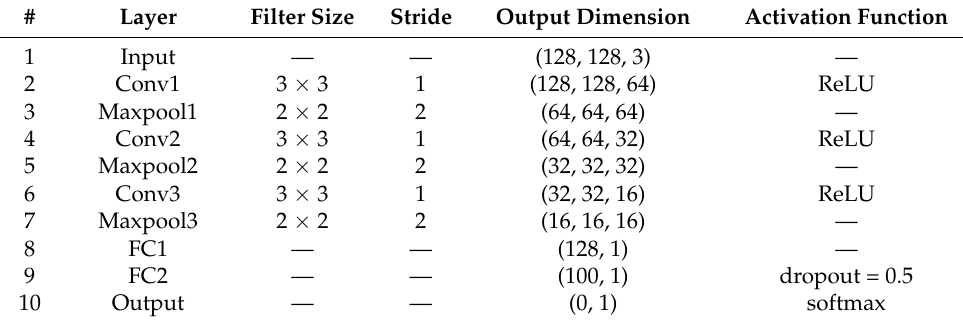
Table 3. The detailed information of the CNN